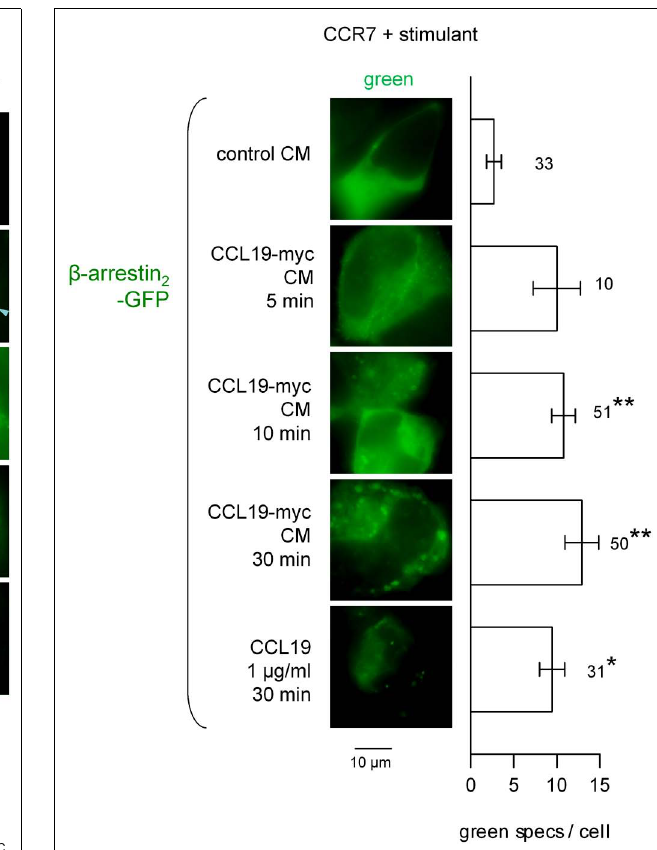
FIGURE 5 | Epifluorescence microscopy studies in cells co-expressing CCR7 and β -arrestin 2 -GFP and stimulated as indicated (stimulant and duration). Stimulation did not include the fluorescent anti-myc antibody. Either CCL19-myc CM or authentic CCL19 frequently condensed β -arrestin 2 at the level of plasma membrane or endosomes. Right: number of green intracellular condensed structures (“specs”) per cell ± SEM. Numbers close to bars indicate the number of evaluated HEK 293a cells. The Kruskal–Wallis test indicated that the values were heterogenous ( p < 10 − 4 ).The effect of each treatment vs. the effect of control CM was evaluated using Dunn’s multiple comparison test. * p < 0.01; ** p < 0.001. RC519848 and containing the equivalent of ∼ 180 ng/ml of